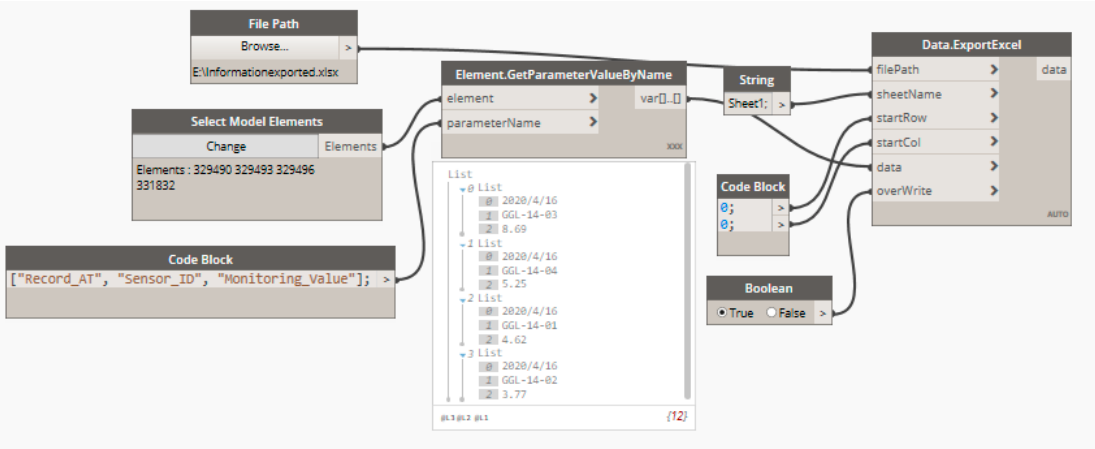
Figure 13. Dynamo nodes of information export from BIM model to Excel file.